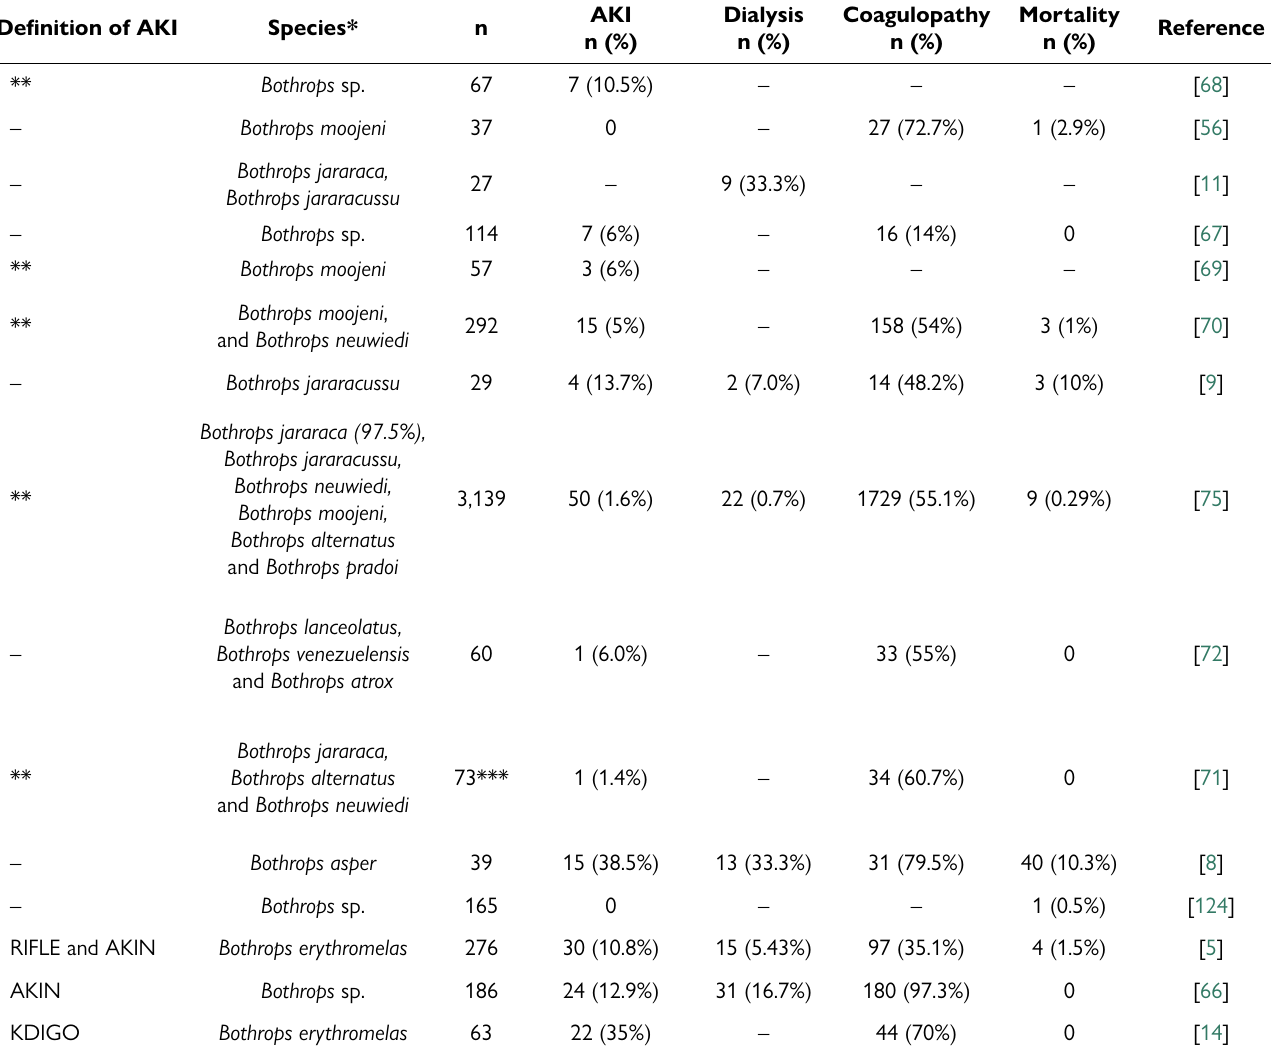
Table 1. Incidence of nephrotoxic AKI after bothropic envenoming. Definition of